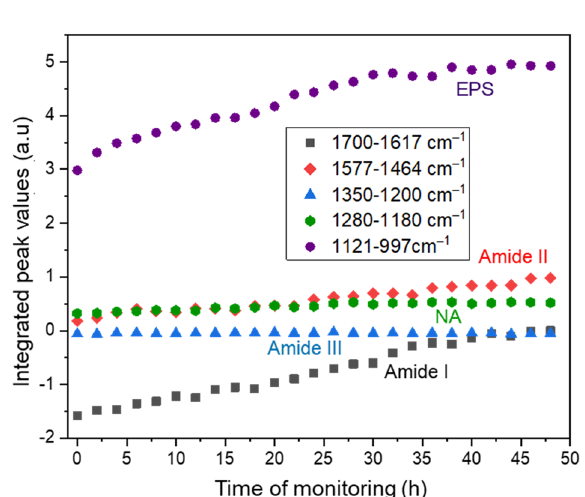
Fig. 8 Temporal progression of characteristic integrated peak areas during 48 h of L. parabuchneri inoculation. (Reference spectrum: MRS medium (0.5 g L − 1 ). Integrated peak areas for amide 1 band (1700 – 1617 cm ‒ 1 , black); amide II band (1577 – 1464 cm ‒ 1 , red); amid III band (1350 – 1200 cm ‒ 1 , blue); nucleic acids (1280 – 1180 cm ‒ 1 , green), and the extracellular polymeric substances (1121 – 997 cm ‒ 1 , purple) are